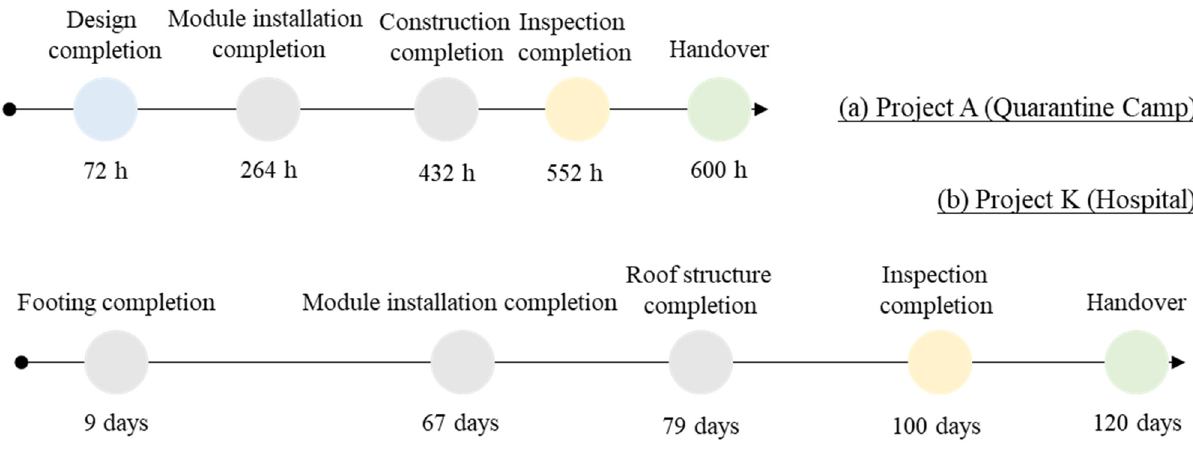
Figure 6. Timeline of project delivery.